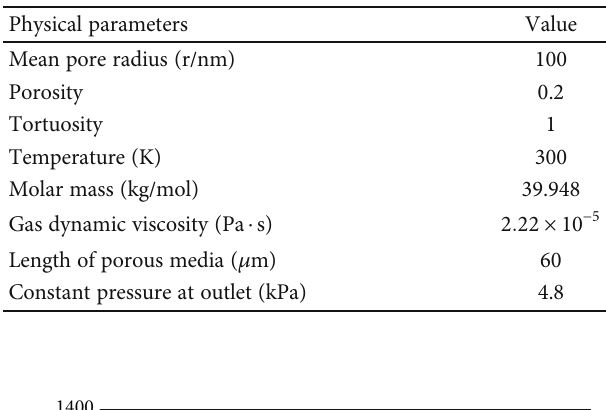
Table 1: Roy et al. ’ s experimental condition and fl uid parameters.